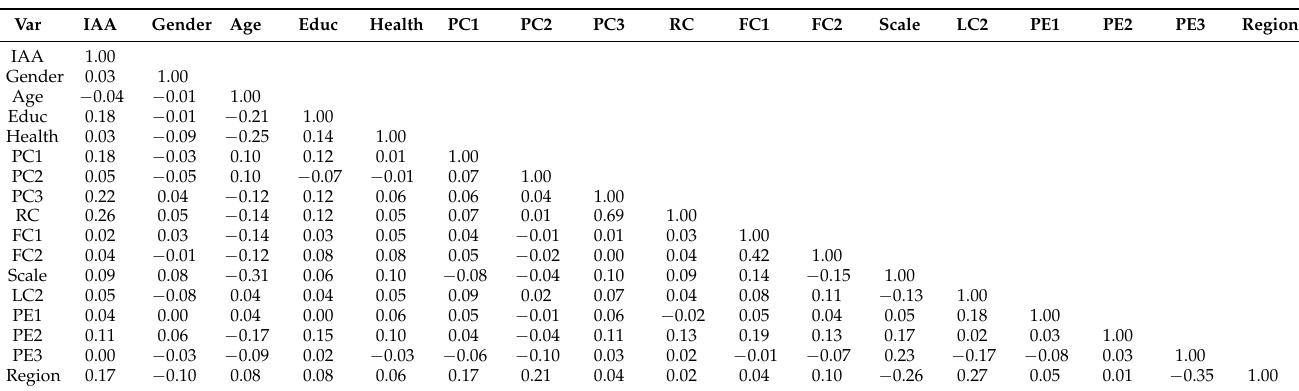
Table A2. Pearson correlation coefficient of each variable.